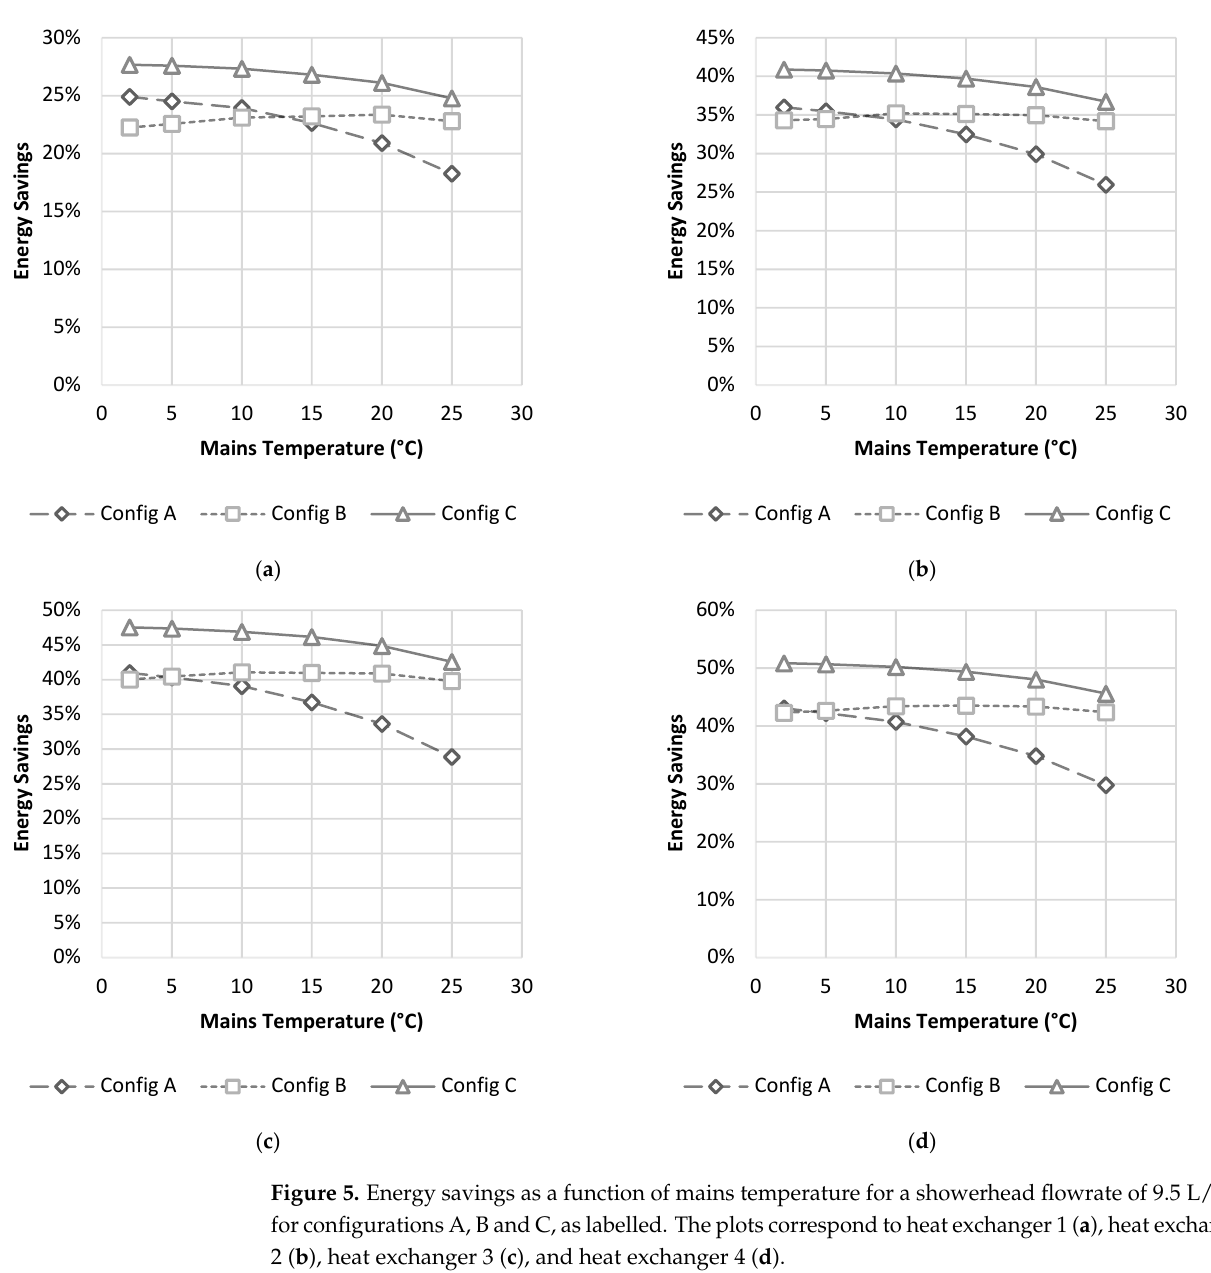
contains six bars, each of which corresponds to a mains temperature (Tm) between 2 and 25 ◦ C, as labelled in the legend. Note that the heat capacity ratios for configuration C are not plotted here, as they are always equal to